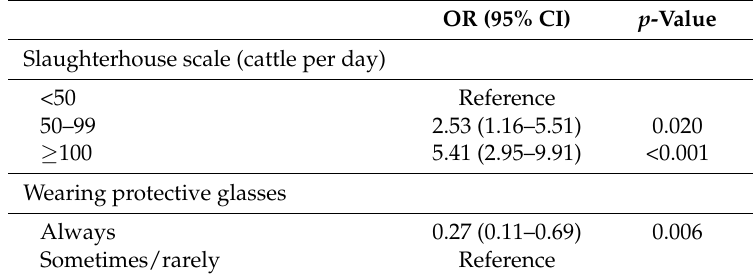
Table 5. Multivariate logistic regression analysis with backward elimination to identify risk factors for brucellosis seroreactivity among cattle slaughterhouse workers in South Korea a